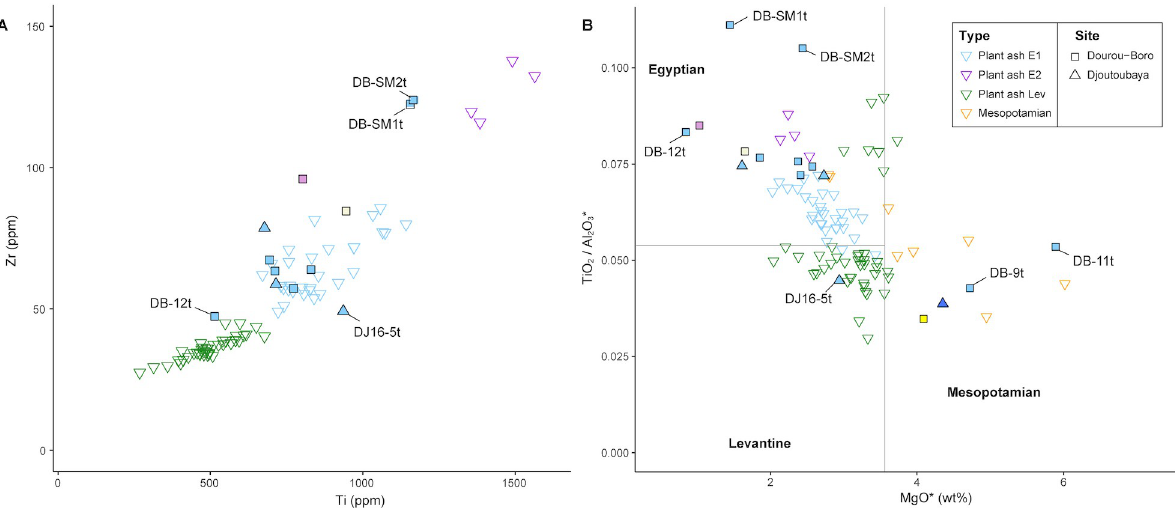
Fig 13. Dourou-Boro and Djoutoubaya glasses compared to Egyptian, Levantine, and Mesopotamian glasses. Titanium oxide to alumina ratio versus magnesia (A) and zirconium versus titanium (B) confirm the probable different origin of the glasses from Dourou-Boro and Djoutoubaya.